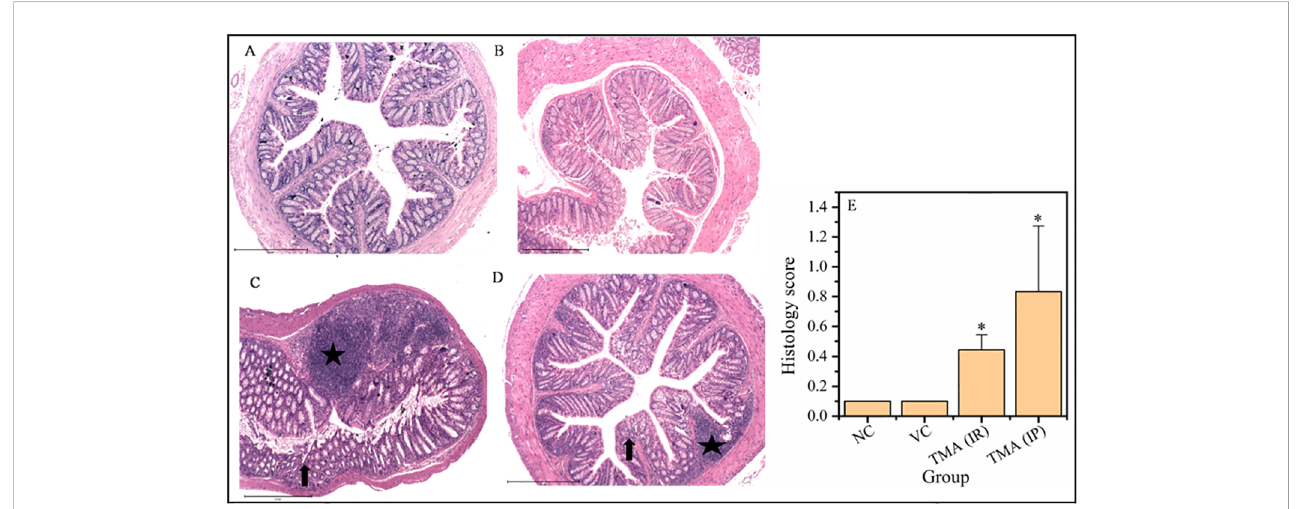
FIGURE 9 Micrographs of the rectum (A-D) and histological score of all groups (E) . H & E sections of rectum from mice exposed to TMA intraperitoneally (IP) (C) and intrarectally (IR) (D) or negative control (A) or vehicle control (B) are shown. Severe in fl ammation characterized by severe cellular in fi ltration persisted in the colon of mice exposed to TMA intrarectally (D) compared to negative and vehicle control. The histology scores for the in fl ammation of these groups are summarized in (E) . Black star points to cellular in fi ltration and black arrow represents crypt distortion in TMA exposed mice rectum. The histological score showed a signi fi cant increase in in fl ammation after TMA exposure. * p